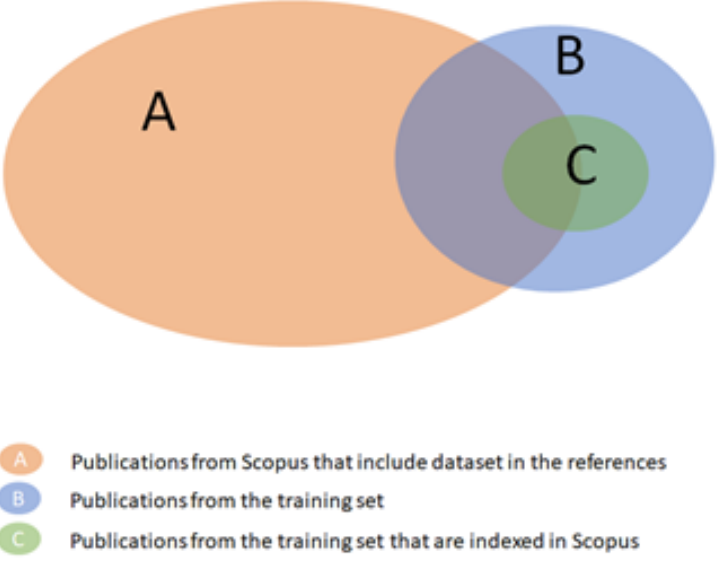
Figure A1. Measuring